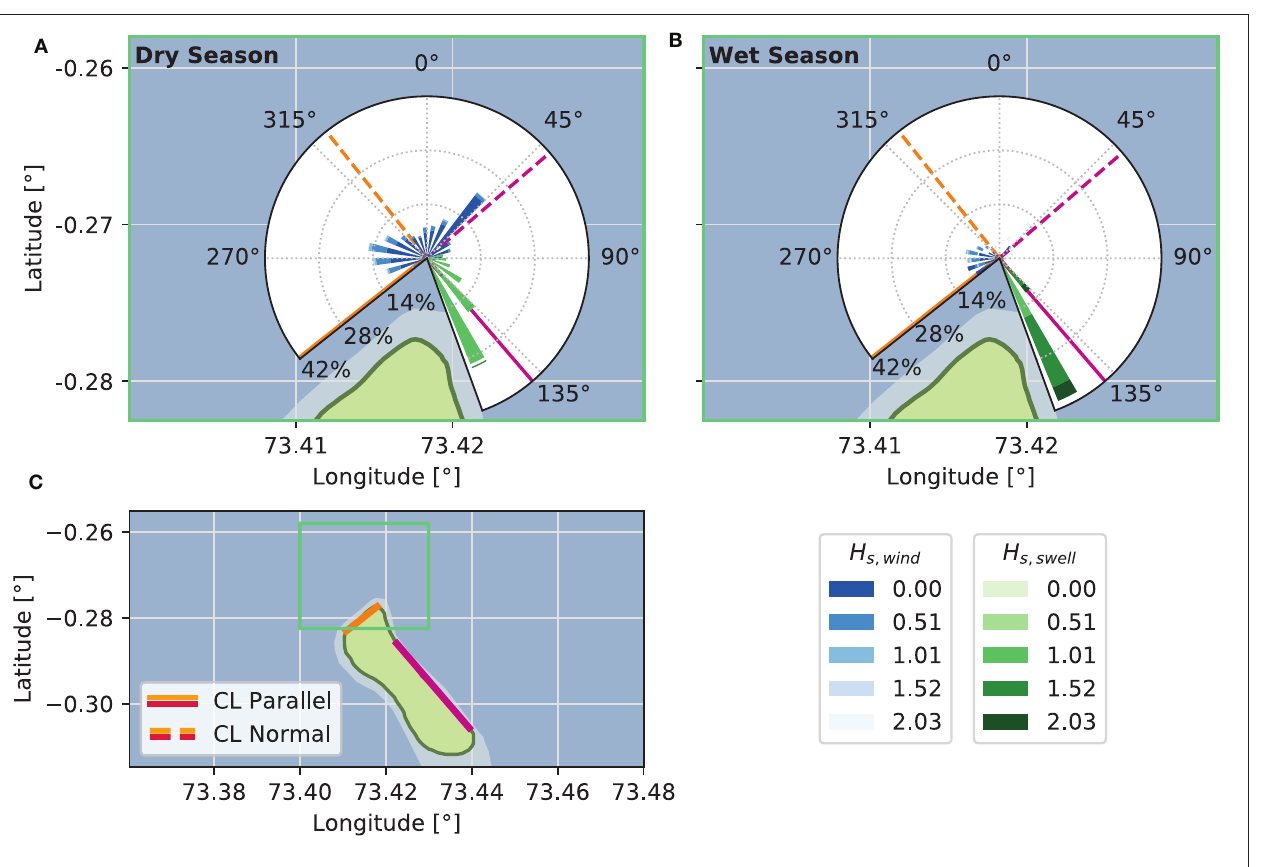
FIGURE 6 | Wave parameter input for the assessment of the evolution of the Thoondu sand spit with the CERC method for (A) the dry season and (B) the wet season. Blue and green bar plots are the wave rose for wind and swell waves. Orange and crimson lines in the wave roses mark the shoreline parallels (solid) and shoreline normals (dashed) of (C) the beaches Geiymiskih (orange, see also Figure 7 ) and Thoondu (crimson, see also Figure 8 ) adjacent to the northern